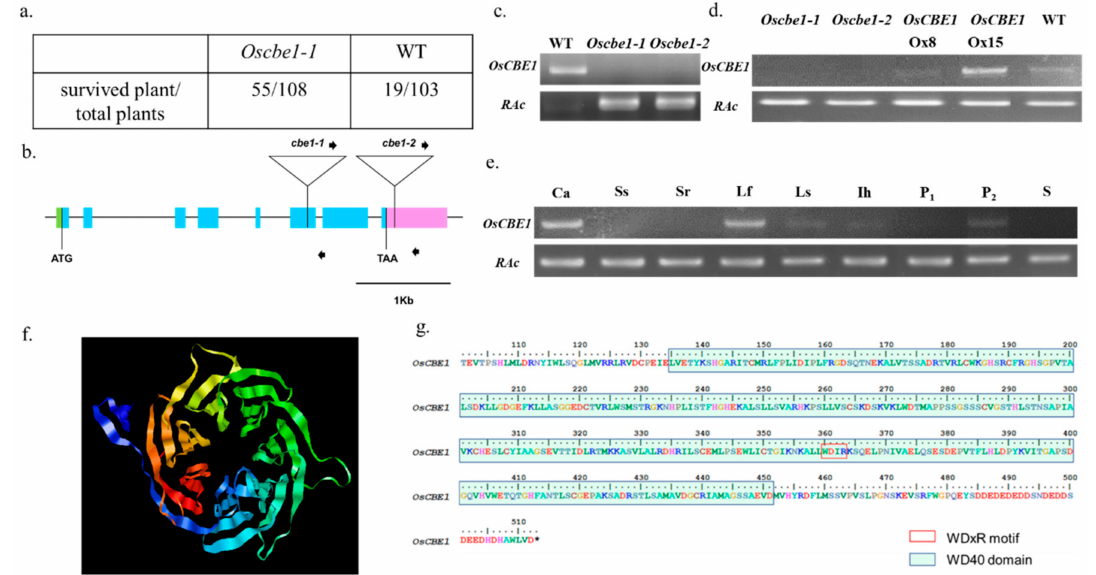
Figure 1. Screening of Cold tolerant E3 ubiquitin ligase line. ( a ) Survival rates of 7d rice seedlings after low temperature treatment. ( b ) Map depicting the tagging position of two allelic T-DNA insertion mutant lines of OsCBE1 . Exons (blue boxes), 5 (cid:48) UTR (green box), 3 (cid:48) UTR (pink box), and introns (lines) are indicated. ( c ) Identification of Oscbe1 T-DNA insertion mutants ( d ) Expression profile of OsCBE1 in mutant and overexpression lines. ( e ) Expression profile of OsCBE1 in different tissues of rice. Ca, callus; Ss, shoots at 7 days after germination (DAG); Sr, roots at 7 DAG; Lf, mature leaves; Ls, flag leaf sheaths; Ih, the highest internode at pre-heading stage; P1, 1–2 cm panicles; P2, 3–8 cm panicles. ( f ) Predicted seven bladed beta propeller structure of WD domains in OsCBE1 protein. Image colored by rainbow N-to C-terminus. ( g ) WD domain of OsCBE1 with WDxR